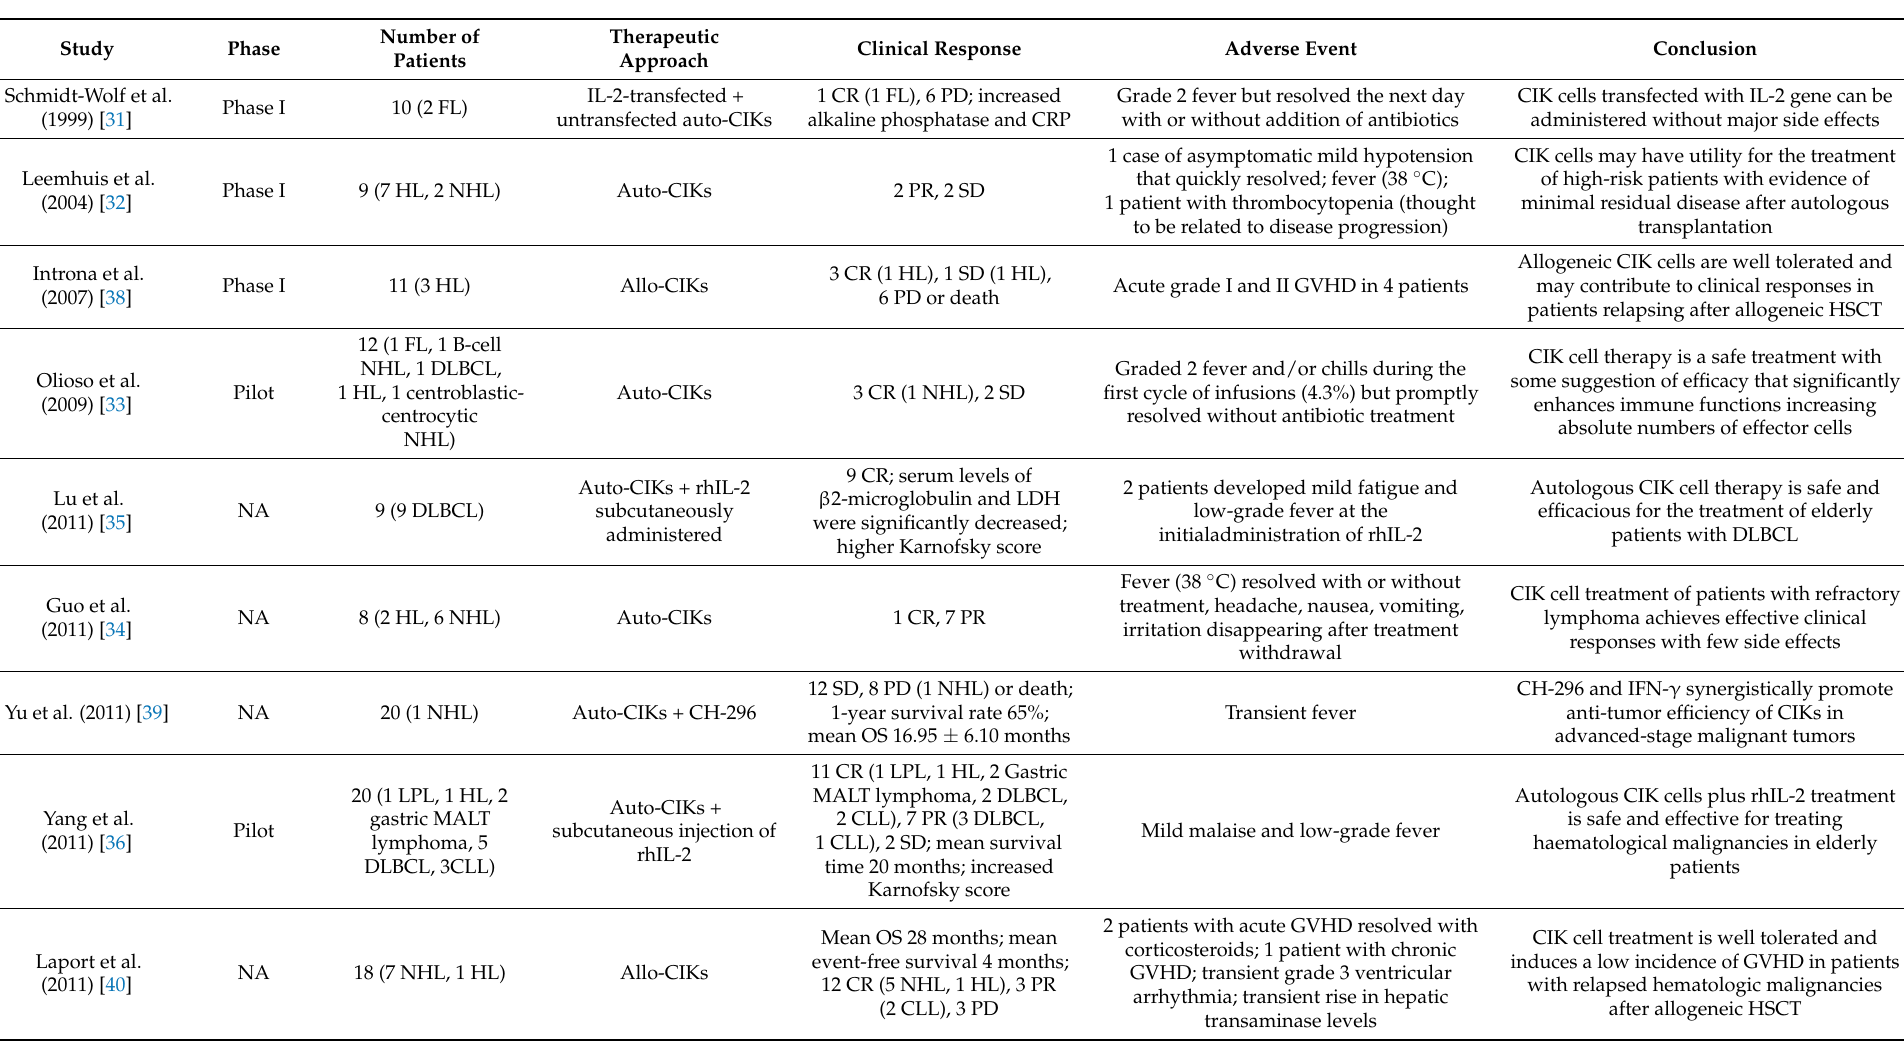
Table 2. Clinical trials based on CIK cell therapy in